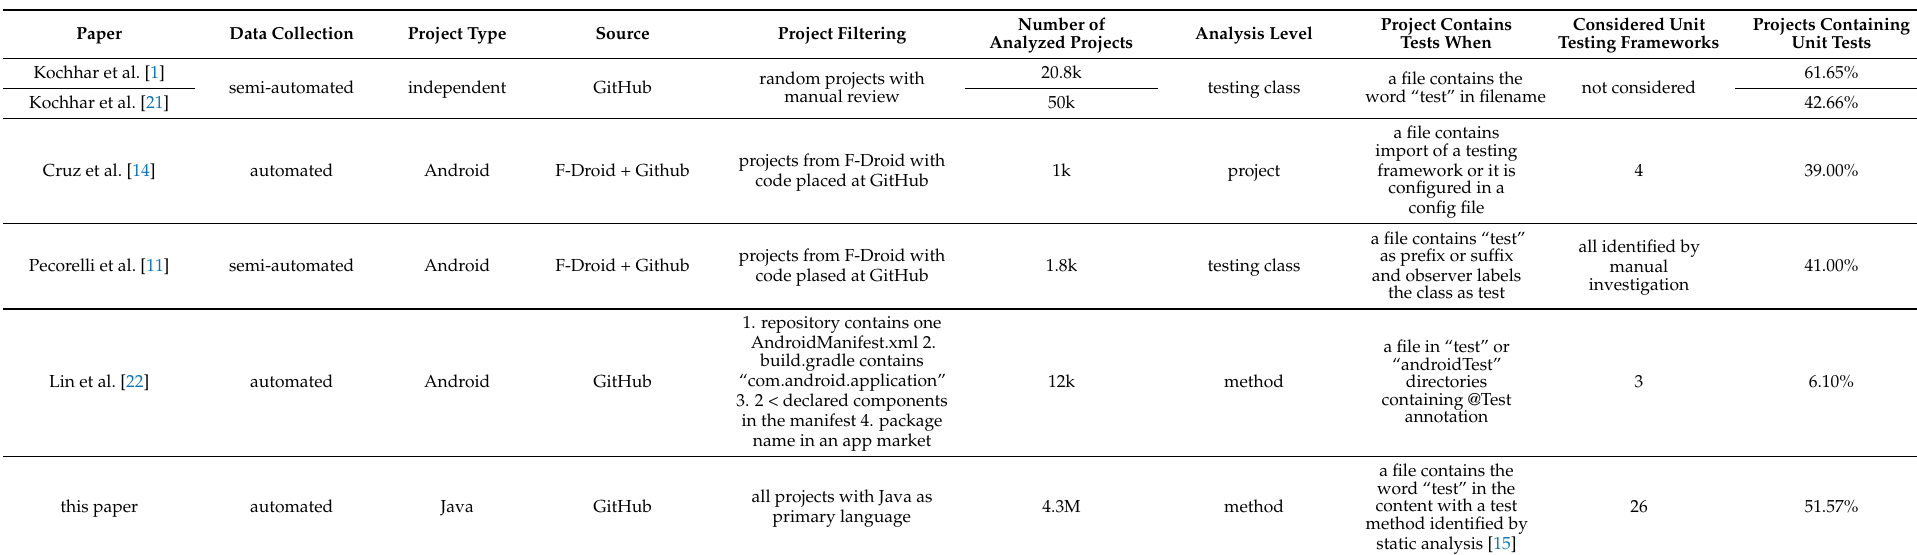
Table 2. The novelty of the study compared to related